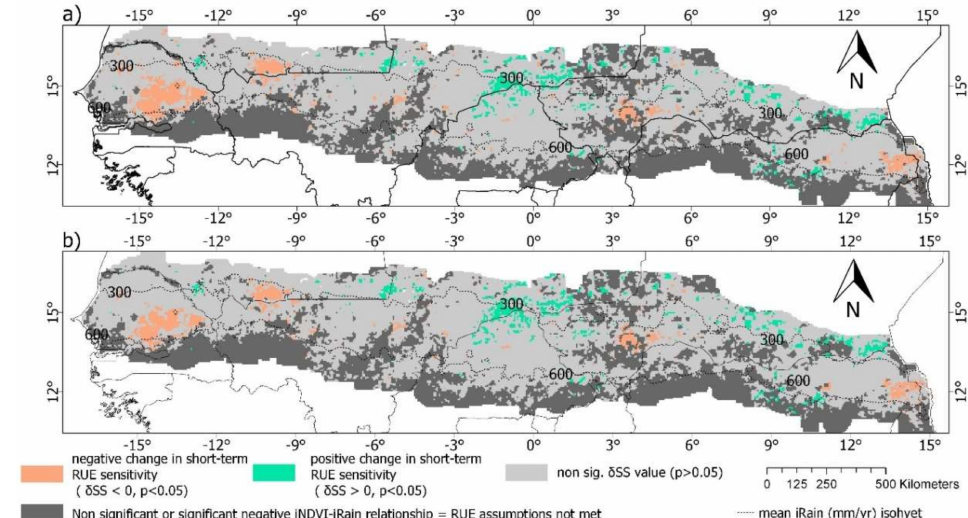
Figure 8. Inter-decadal change in short-term RUE sensitivity ( δ S S : change in the slope of i NDVI- i Rain relationship): ( a ) assuming a linear i NDVI– i Rain relationship, ( b ) following AIC model-selection between linear and saturating